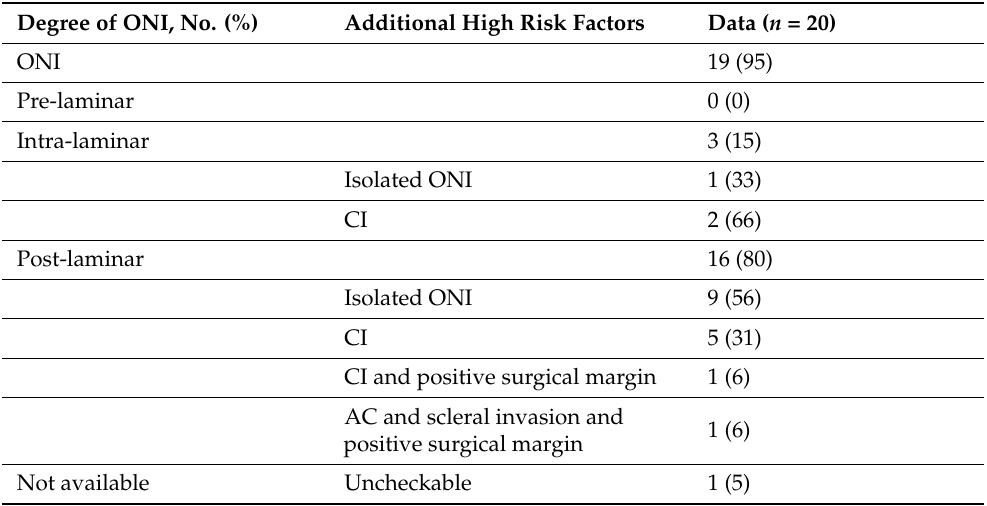
Table 2. Histological high-risk factors